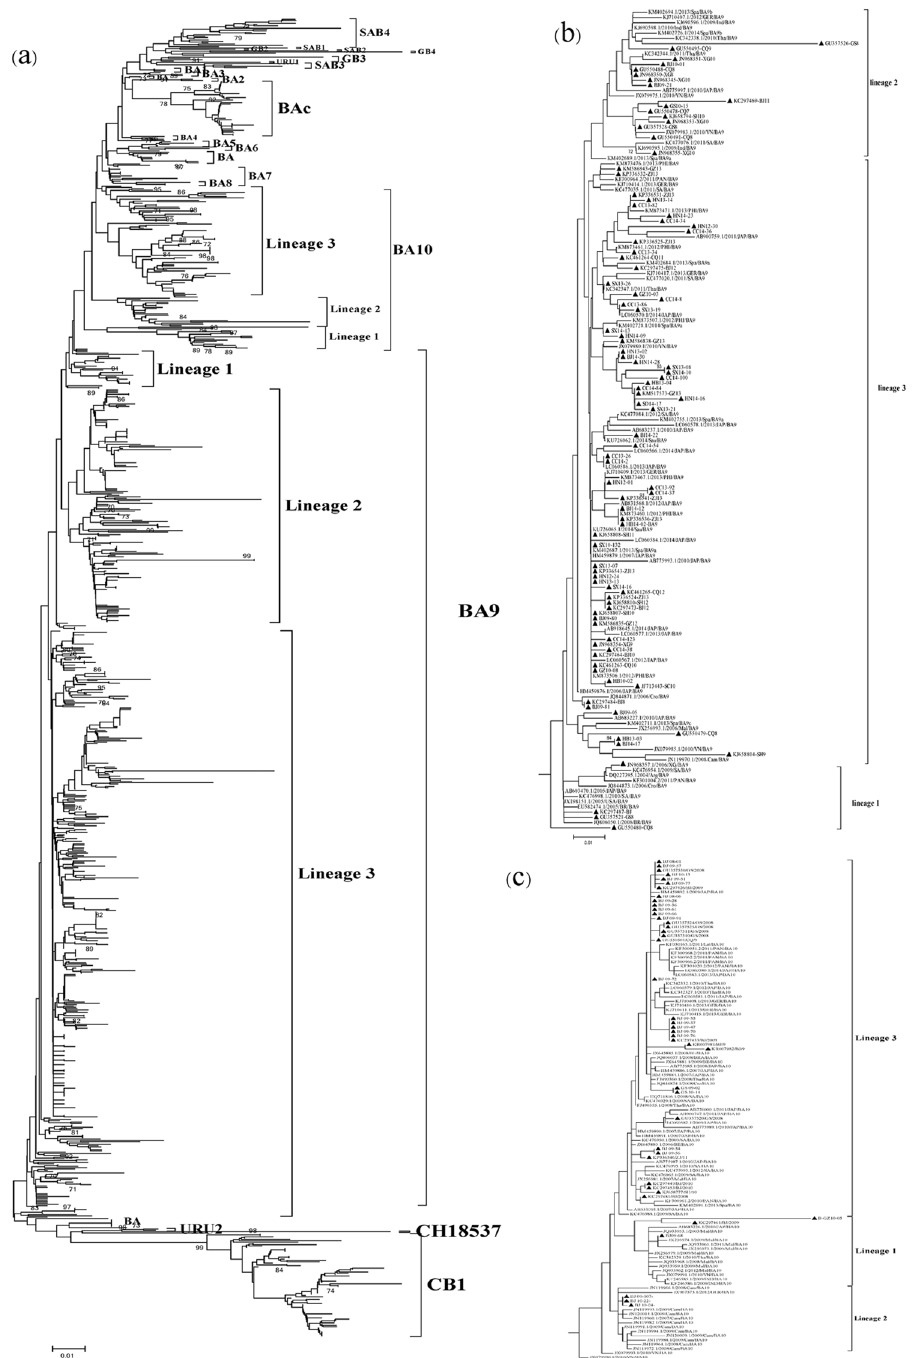
Figure 2. ( a ) Phylogenetic tree of 697 Chinese HRSVB sequences from 1991 to 2014 with reference sequences from Genbank. ( b ) Phylogenetic tree of 92 BA9 sequences from China and 64 BA9 reference sequences from other countries. ( c ) Phylogenetic tree of 43 BA10 sequences from China and 71 BA10 reference sequences from other countries. Chinese sequences were denoted by triangles in Fig. 2b,c. A detailed tree of Fig. 2a is shown in Supplementary Figure